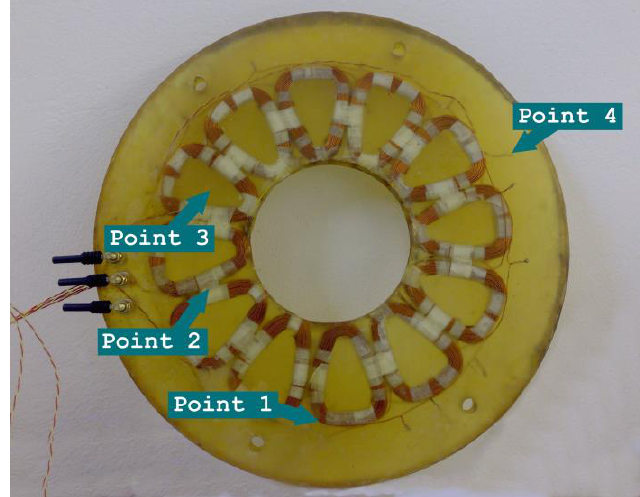
Figure 13. Constructed stator with the temperature measuring points indicated.